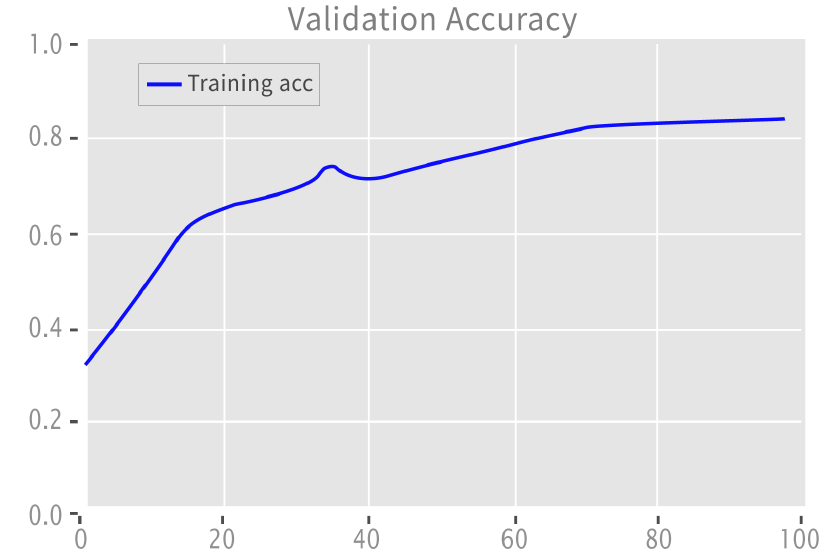
Figure 9. Validation accuracy: